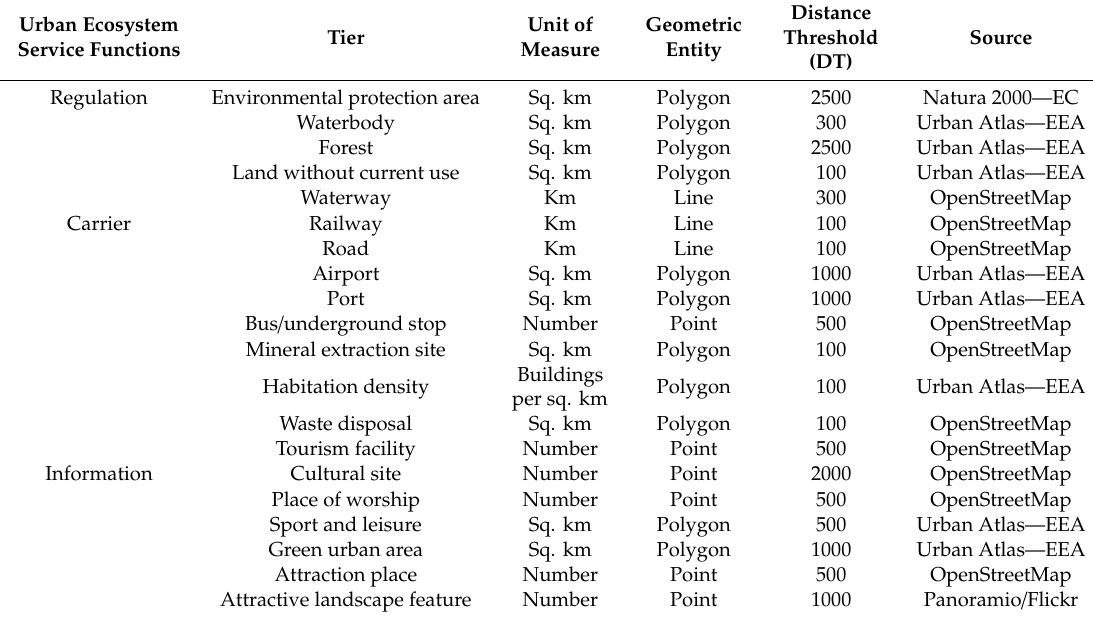
Table 1. Urban Ecosystem Service